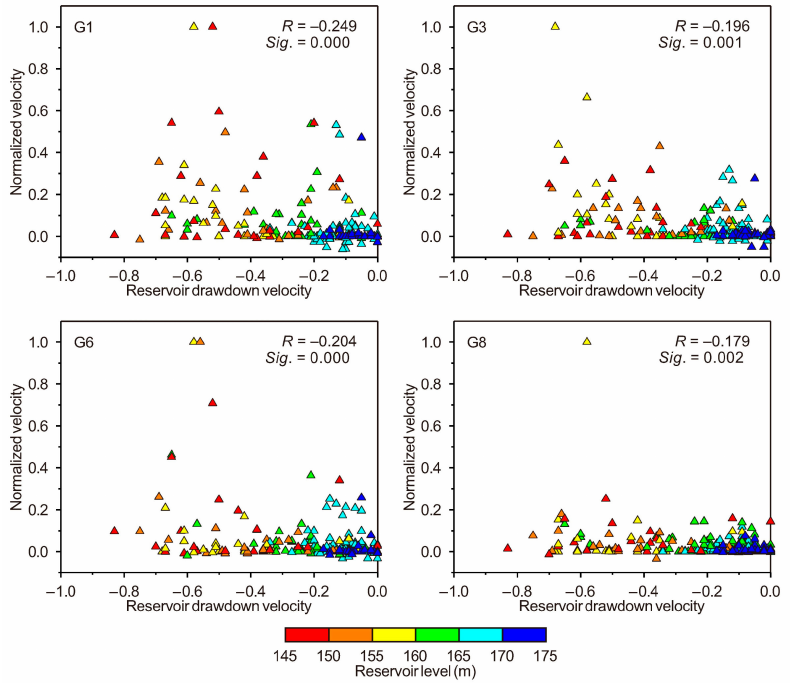
Figure 16. Correlation between reservoir drawdown velocities and normalized horizontal velocities measured at the GNSS stations. The color of the triangles indicates the reservoir level. (Note: R is the Pearson correlation coefficient and Sig. is the significance; the value of Sig. less than 0.05 means significant